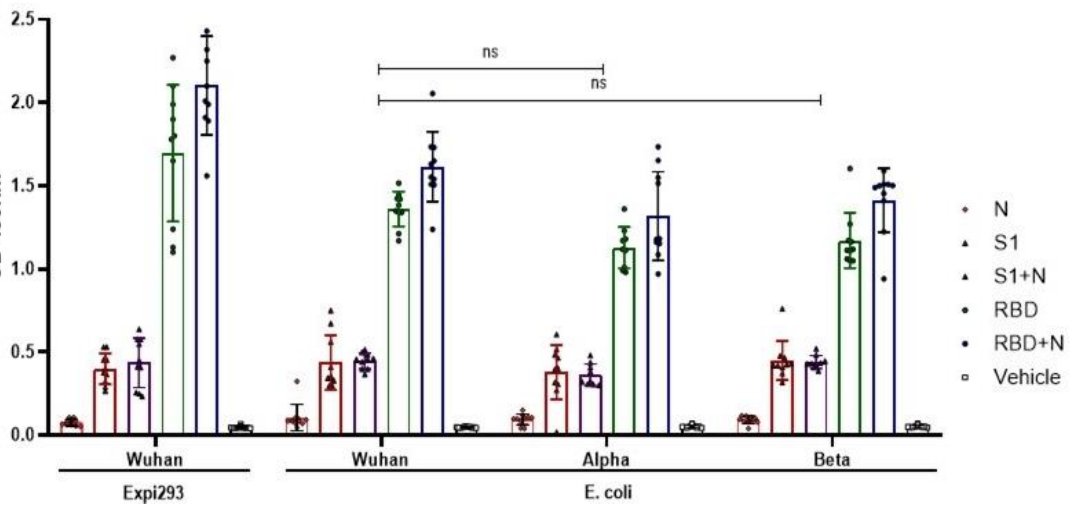
Figure 7. Recognition of RBD variants by sera from immunized mice. IgG antibodies against RBD Wuhan, Alpha, and Beta were evaluated using ELISA. Sera were diluted to 1:200. IgG antibodies were observed in response to RBD variants expressed in the E. coli system. Lower levels of these antibodies were detected in the variant groups than in the RBD Wuhan group, although the difference was not statistically significant. Bars represent the mean ± SD. * p < 0.05, ** p < 0.01, *** p < 0.001. p ≤ 0.05 was considered statistically significant. The Wilcoxon test in Prism v.8 software was used for statistical analyses (GraphPad Inc., La Jolla, CA, USA).